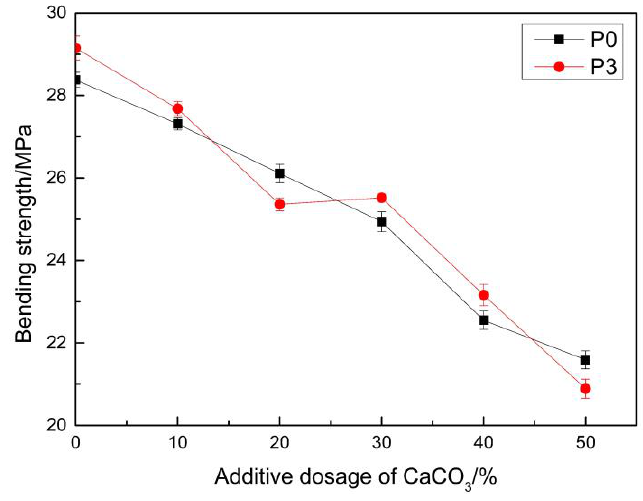
Figure 8. Effect of different CaCO 3 ratios on the bending properties of materials.